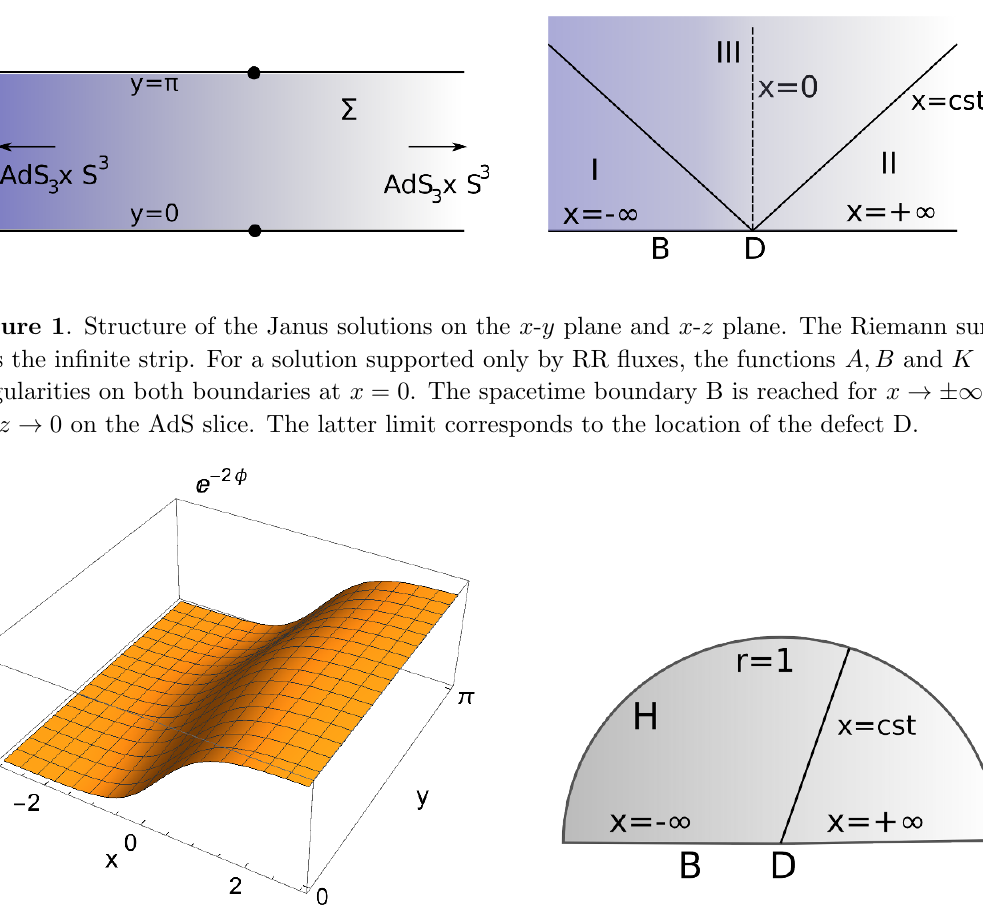
Figure 2 . Dilaton pro(cid:12)le for the supersymmetric Janus solution with = 1 ; (cid:18) = 0 in the x (cid:0) y plane (left) and sketch of the (cid:12)nite-temperature solution (right). The black-hole horizon H is located at r = 1, the defect D is located at r =